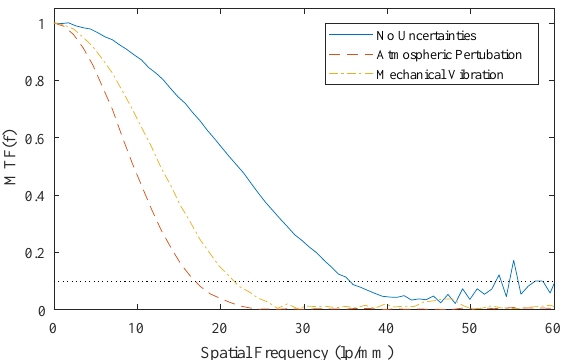
Figure 10. MTF plots of the system with no uncertainties, with simulated atmospheric turbulence, and with simulated mechanical vibrations. Table 6. Spatial-resolution results for the virtual dosimeter under different uncertainty scenarios.